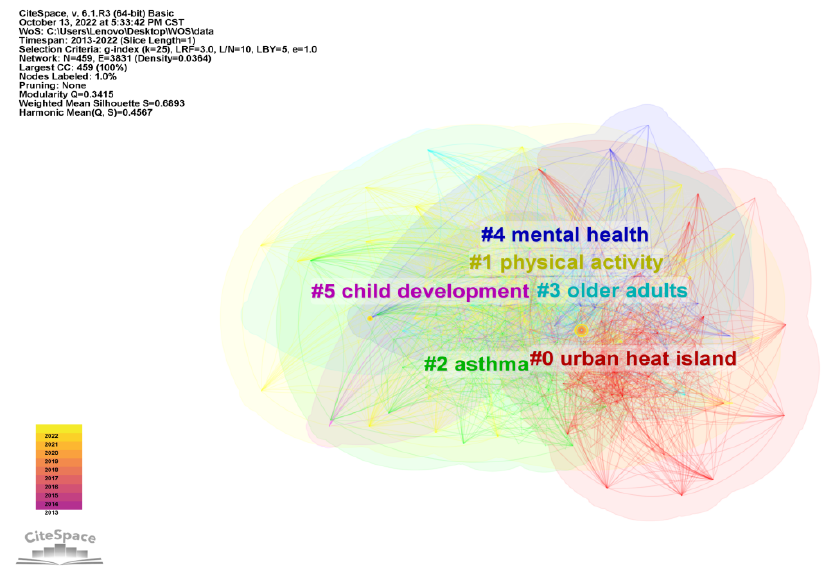
Figure 16. Keywords clustering in rural human settlements research.